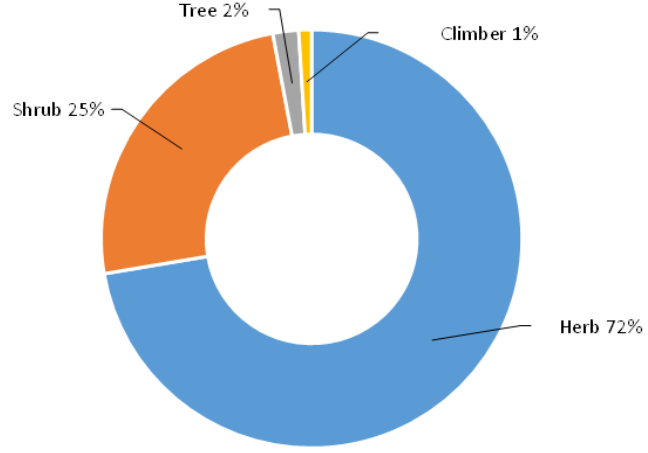
Figure 5. Habitat class of plant species in the arid and desert rangelands of Tataouine, Tunisia (spring 2018).